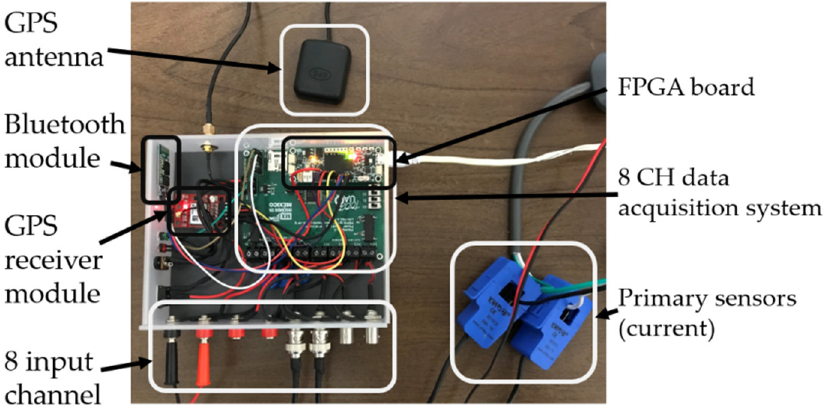
Figure 5. Image of the proprietary GPS (GSD).